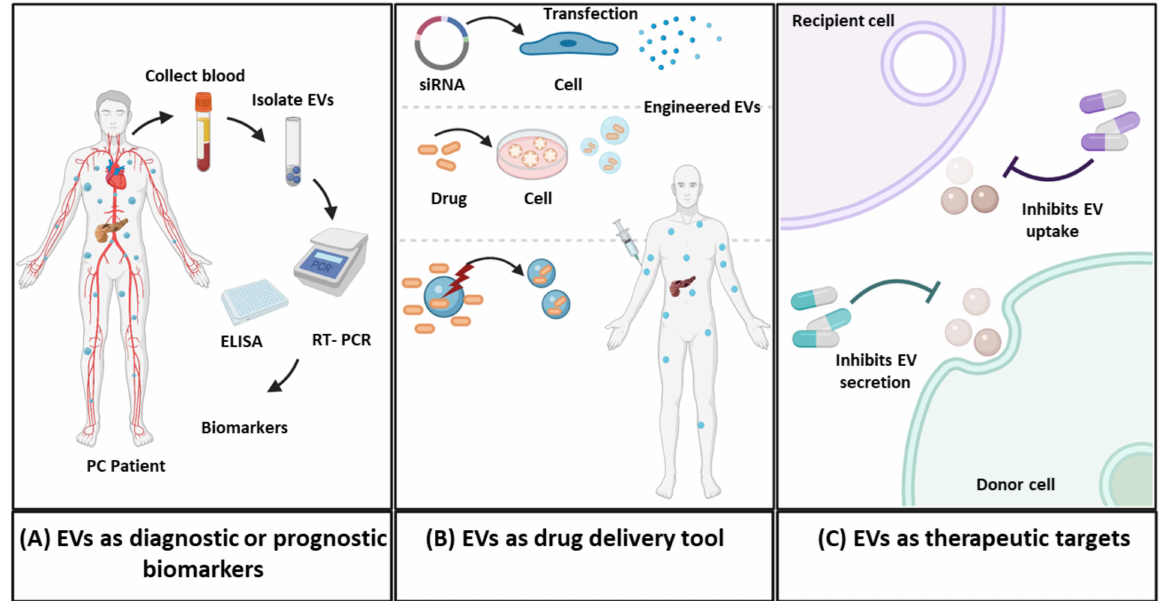
Figure 3. Potential applications of extracellular vesicles (EVs) in diagnosis and treatment of pancreatic cancer (PC). ( A ) EVs and their contents have promising potential to serve as highly specific early diagnostic and prognostic biomarkers. Isolating EVs from the plasma of patients and evaluating the expression patterns of miRNA and proteins in EVs could be utilized to discriminate between PC and non-malignant patients. ( B ) EVs can serve as an attractive targeted drug delivery tool for the treatment of PC. As shown, different methods can be used to engineer EVs to carry siRNA, proteins and chemotherapeutics to the recipient cells for treating PC. ( C ) Strategies to block EV release from cancer cells or inhibiting EV uptake by the recipient cells could be a potential therapeutic target for PC. Created with https://biorender.com/ (8 October